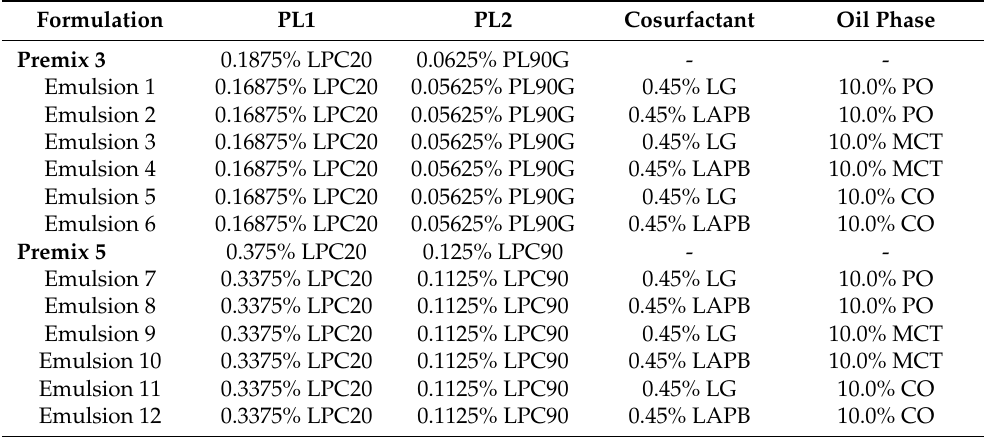
Figure 6. Comparison of the foams generated from Premix 5 + 10.0% MCT with and without a cosurfactant; mean ± SD, n = 3; ** p ≤ 0.01. Table 4. Compositions of the investigated